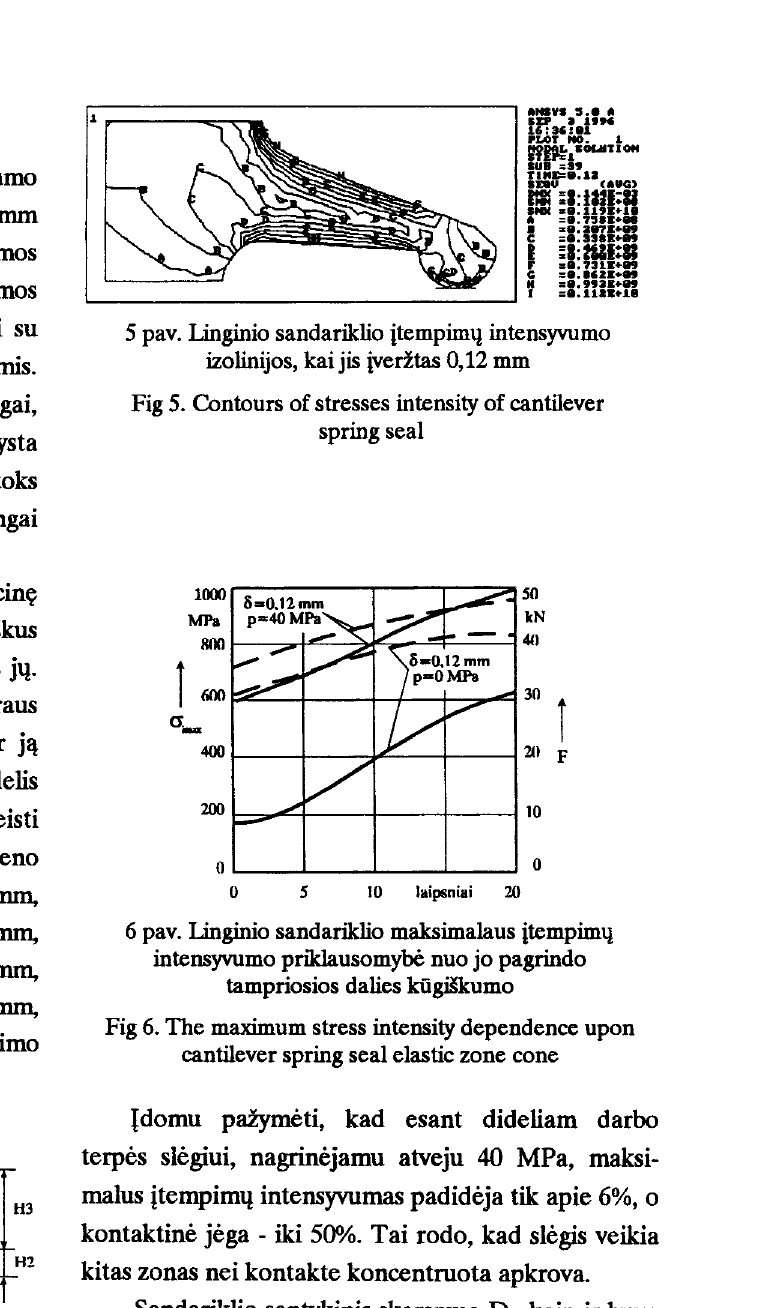
Fig 4. Computational scheme of V and A. form seal